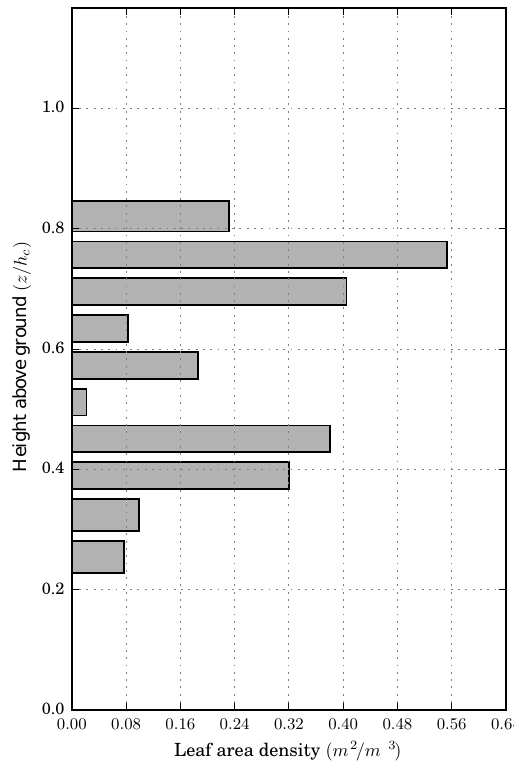
Figure 2. Simulated leaf area density profile corresponding to the forest canopy at the Tumbarumba site used in this